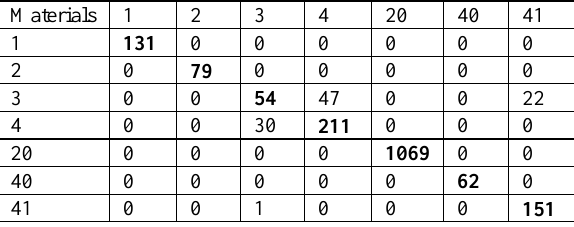
Table 2. Confusion matrix of lineal kernel function, calculated on the rectified image of 2013 (30 cm/px)